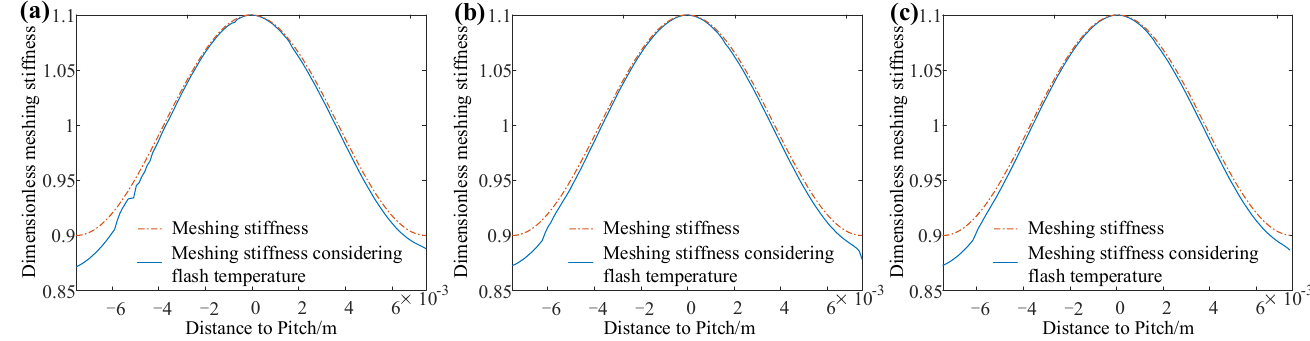
Figure 7. Meshing stiffness with different fractal dimension D . ( a ) D = 1.43. ( b ) D = 1.5. ( c ) D = 1.6.